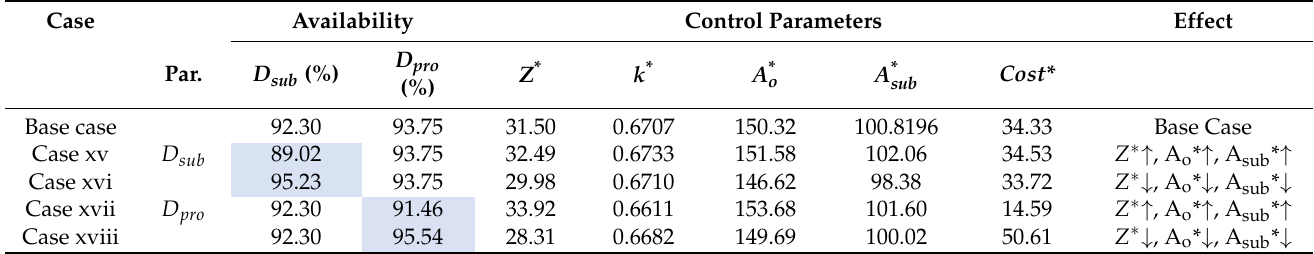
Table 9. Effect of the variation of the producer and subcontractor